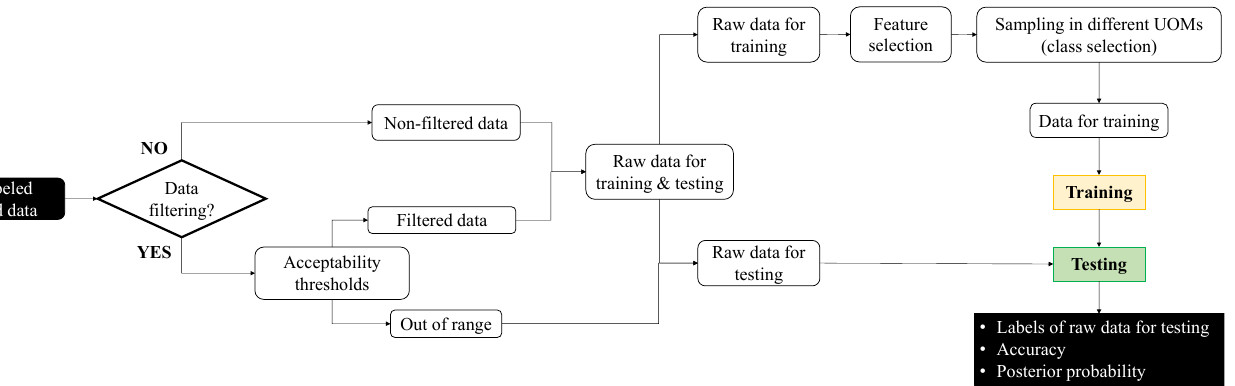
Figure 1. Flowchart of the procedure for identifying the data used for training and testing the classifiers. First, each piece of field data is labelled with the supposed label.